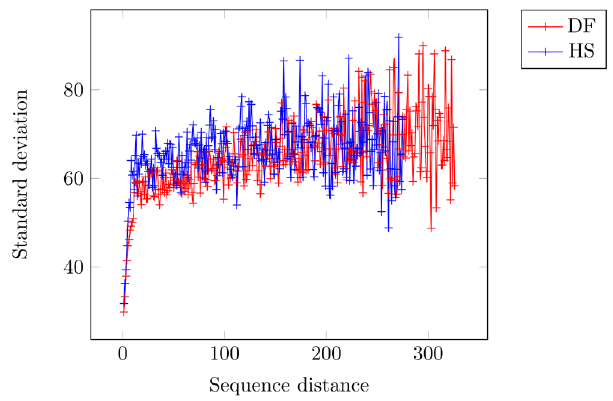
Figure 4. Standard deviation (SD) of the electrostatic potential difference between C β atoms increases with increasing sequence distance for amino acid pairs. Each sequence distance has at least 30 sample points. DF: Aspartic-acid/Phenylalanine, HS: Histidine/Serine. As expected, there is lesser correlation in the EPD values between the shown amino acid pairs ‘DF’ and ‘HS’ as the sequence distance between the residues increases. The SD for distance 1 (i.e. consecutive residues) is 29.8 EPD units and 31.8 EPD units for ‘DF’ and ‘HS’, respectively - and rises to around 60 EPD units with increasing sequence distance.